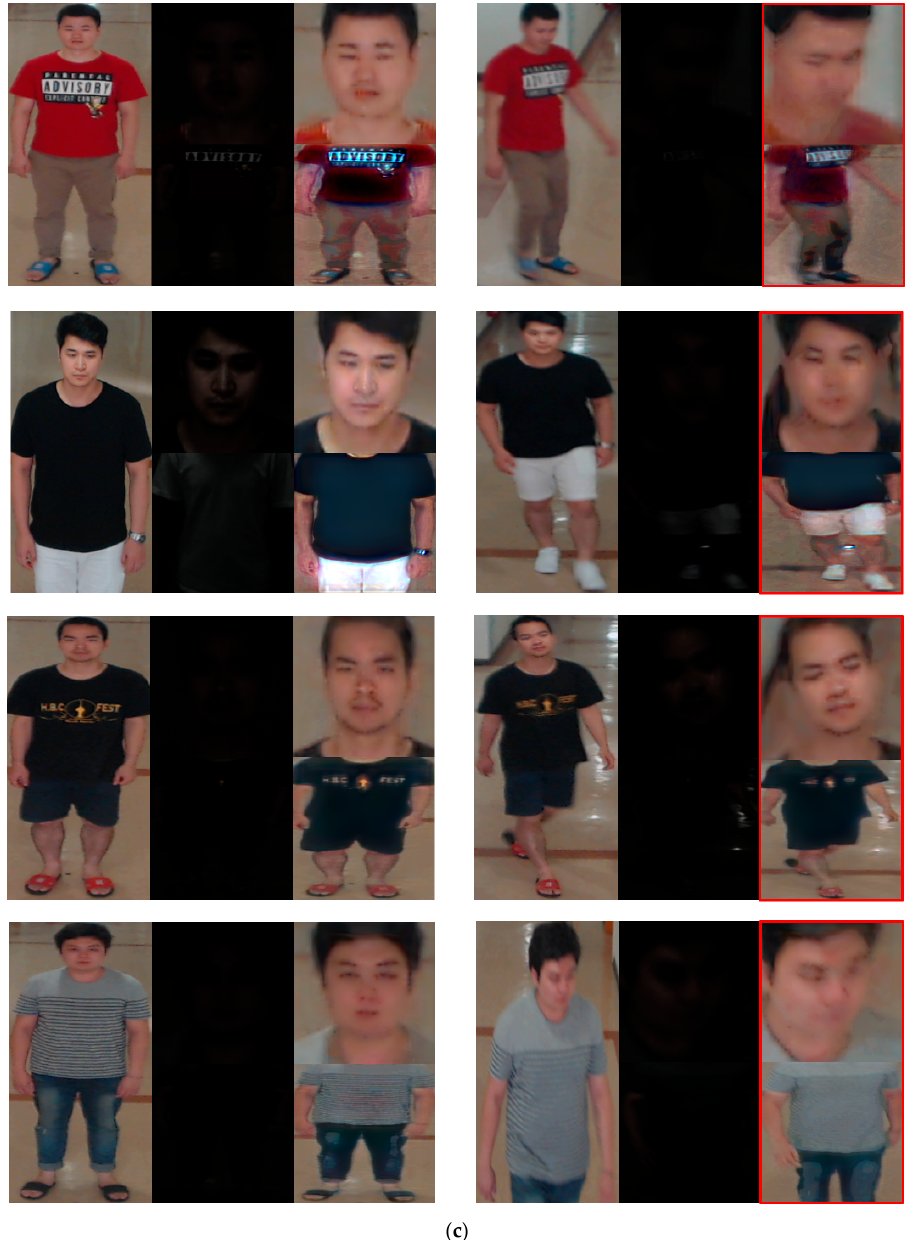
Figure 13. Cases of FA, FR, and correction recognition. ( a ) Cases of FA, ( b ) cases of FR, and ( c ) correct cases. In ( a – c ), left and right images are enrolled and recognized images, respectively.